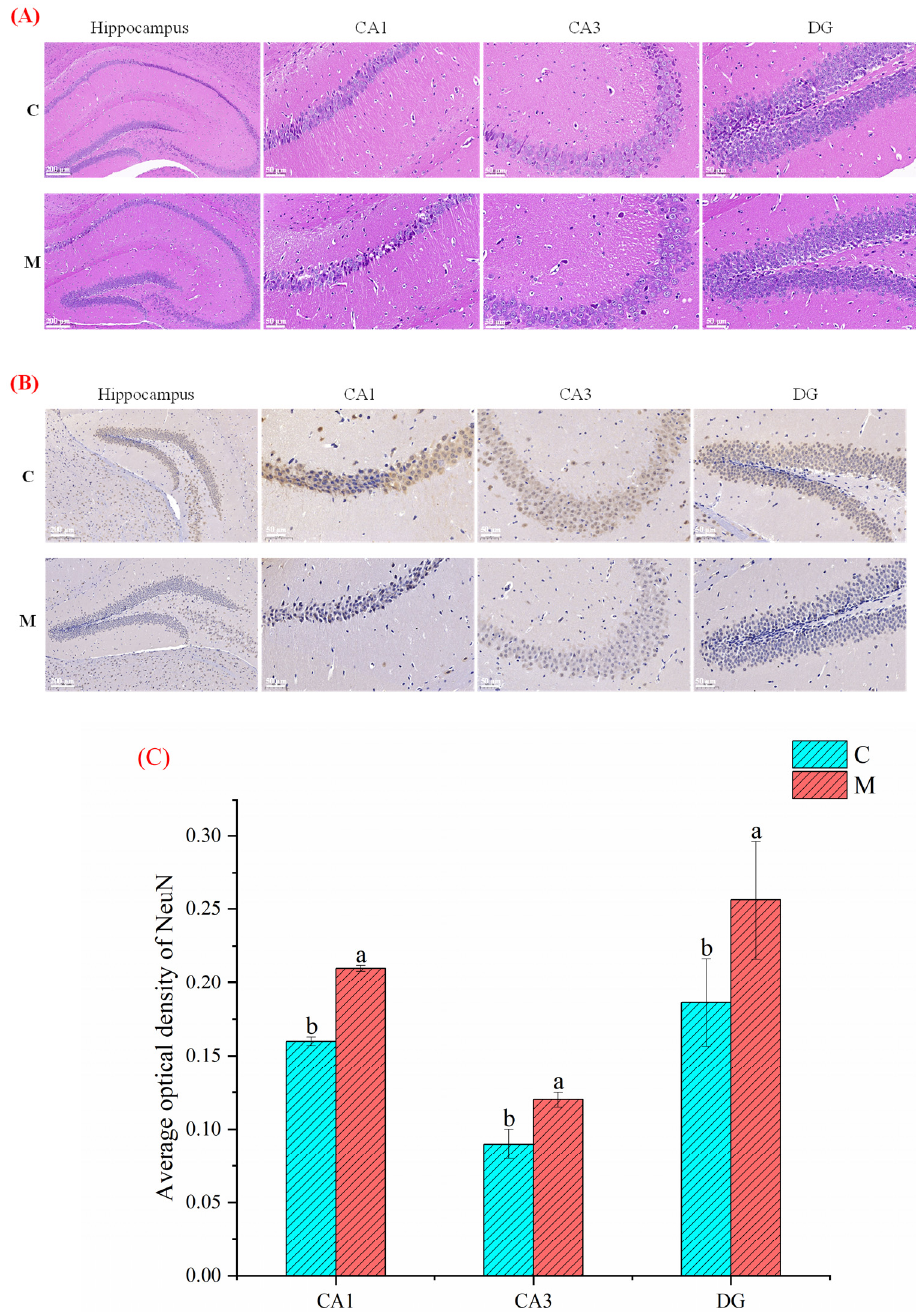
Figure 2. Effect of MFGM on hippocampal neurons in mice: ( A ) H and E; ( B ) Nissl staining of the mice’s hippocampus, dentate gyrus (DG), CA1 and CA3 region. Scale bars = 50 µm in CA1, CA3, and DG; Scale bars = 200 µm in hippocampus; and ( C ) The average optical density (AOD) of NeuN (neuronal nuclei) in the CA1, CA3, and DG region. All experiments were in triplicate. Different lowercase letters (a, b) in ( C ) means significant statistical differences. Capital letters “C” and “M” in ( A , B ) represent control and experimental groups, respectively. Data are presented as mean ± SEM, p < 0.05 compared to the control group.